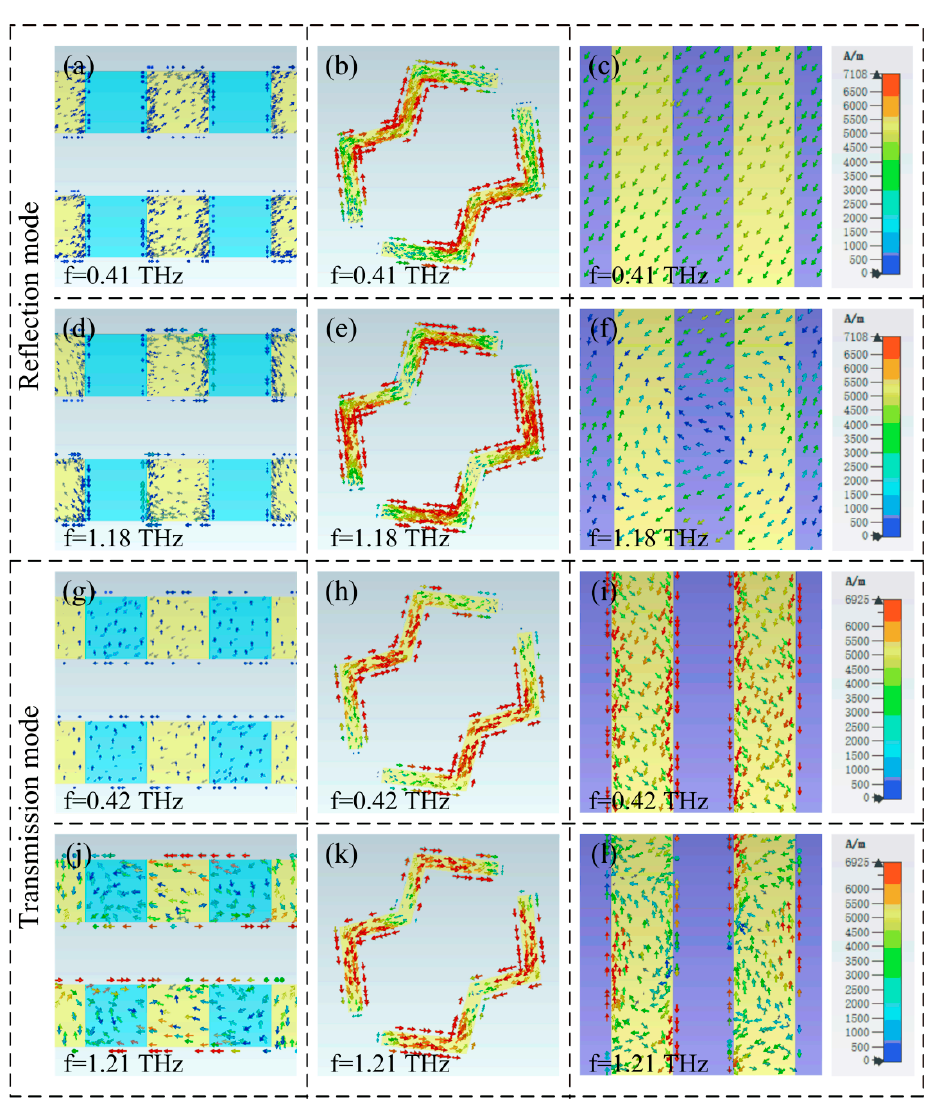
Figure 8. Surface current distribution of ( a – f ) Reflection mode; ( g – l ) Transmission mode.